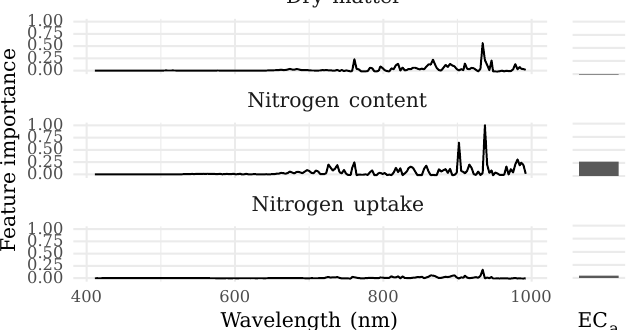
Figure 6. Permutation importance of input features corresponding to the highest-performing models. These were Gaussian process regression models with the squared exponential kernel trained to raw push-broom hyperspectral reflectance data augmented with apparent soil electrical conductivity measurements. The predicted crop property is indicated above each row. The feature importance is given on the R 2 scale. EC a —apparent soil electrical conductivity.